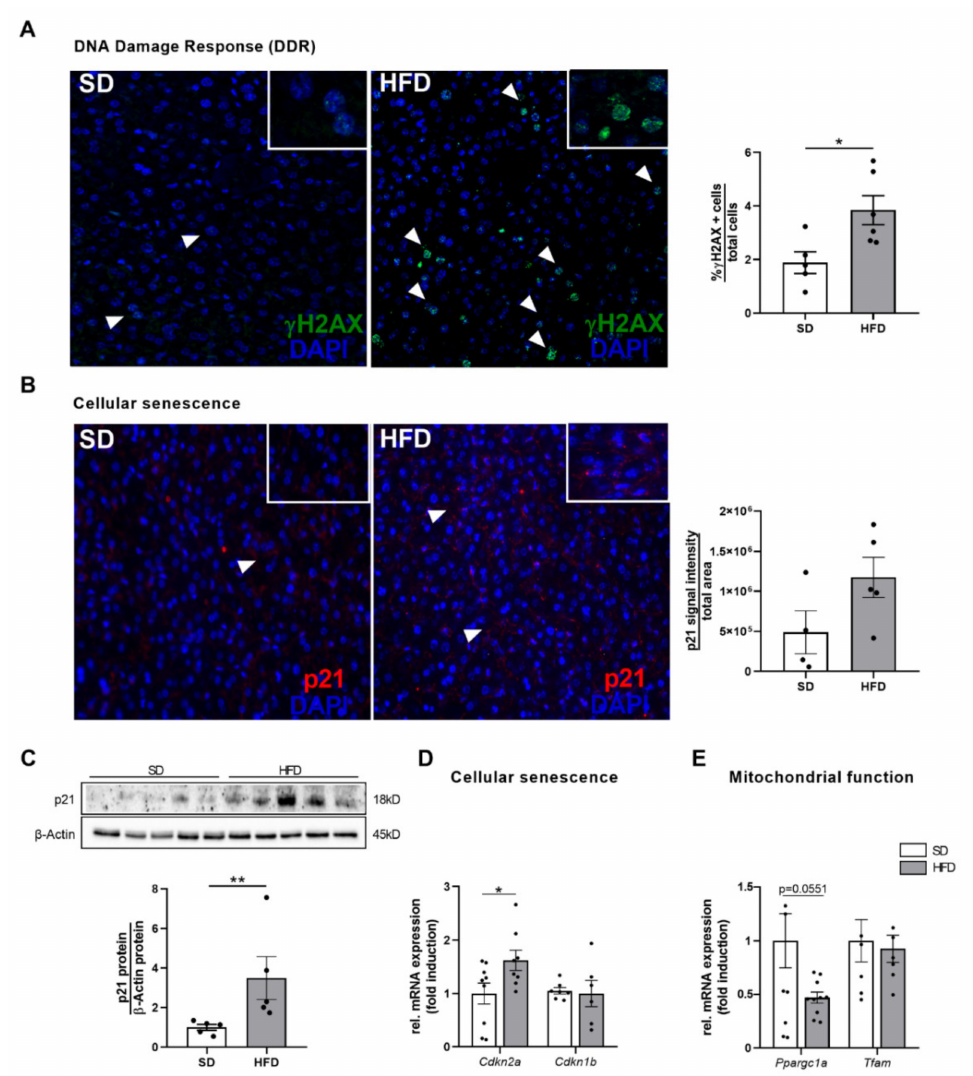
Figure 5. Perinatal obesity causes increased expression of hepatic markers of DNA damage response (DDR) and cellular senescence. ( A ) Assessment of hepatocellular DDR using immunofluorescence staining for γ H2AX. Representative images ( × 10 magnification) of γ H2AX + cells, white arrows depict γ H2AX stained cells. ( B ) Quantification data of γ H2AX + cells relative to all (DAPI) cells (n = 5 per group). ( C ) Assessment of p21 as marker of hepatocellular senescence using immunofluo- rescence staining. Representative images for p21 + cells ( × 10 magnification), white arrows depict